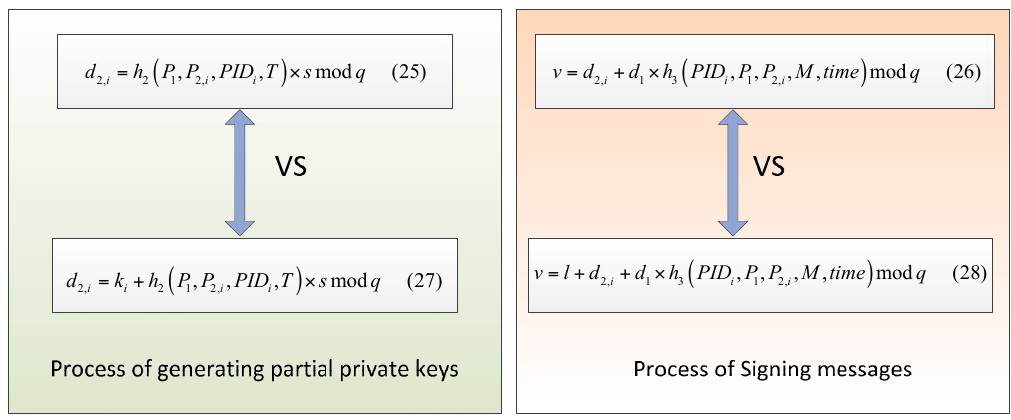
Figure 6. Comparison of two different schemes.